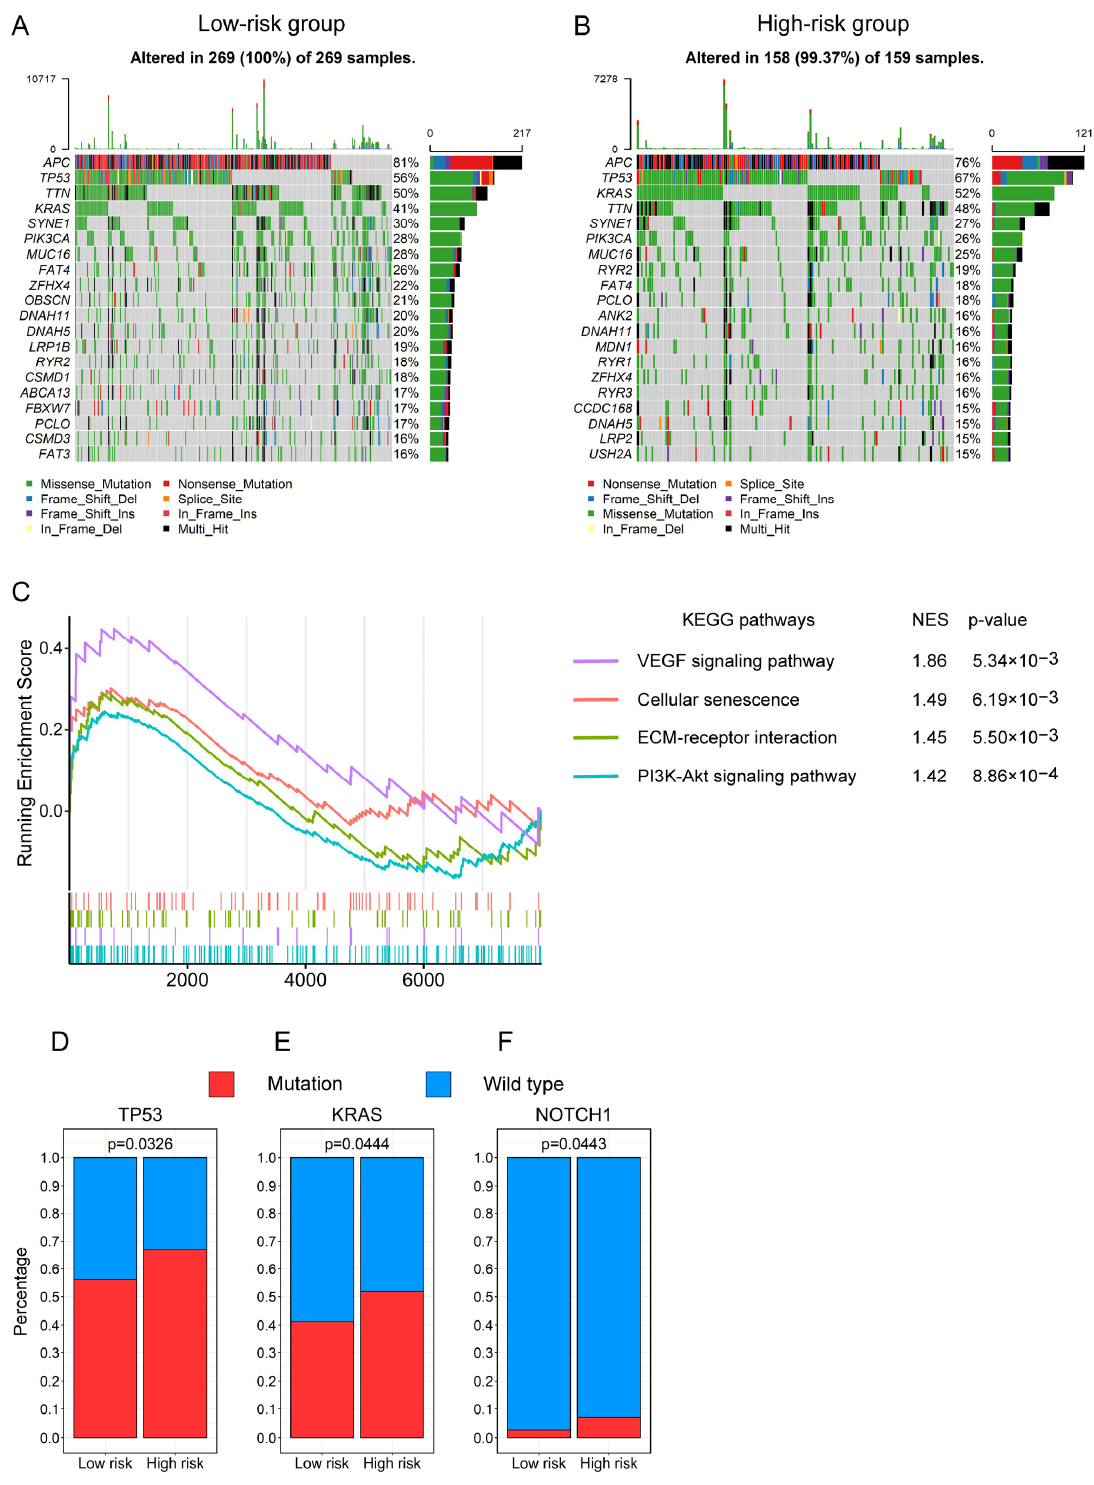
Figure 9. The somatic mutation landscape of CRC patients between the high- and low-risk groups. Waterfall plots display the distribution of variant classifications of the top 20 genes with higher mutation frequencies in the low-risk group ( A ) and high-risk group ( B ). ( C ) The significantly enriched KEGG pathways between the high- and low-risk groups in the somatic mutation data through the GSEA. Bar plots show the different mutation frequencies of TP53 ( D ), KRAS ( E ), and NOTCH1 ( F ) genes between the high- and low-risk groups in the somatic mutation